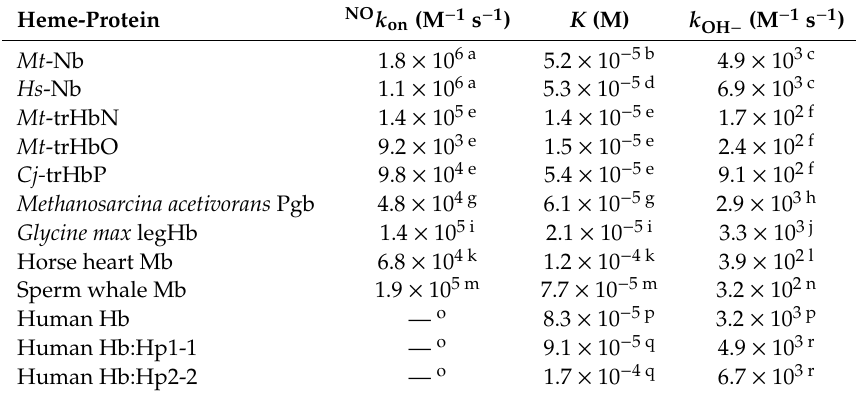
Table 1. Values of NO k on , K , and k OH − for the reductive nitrosylation of ferric heme-proteins.